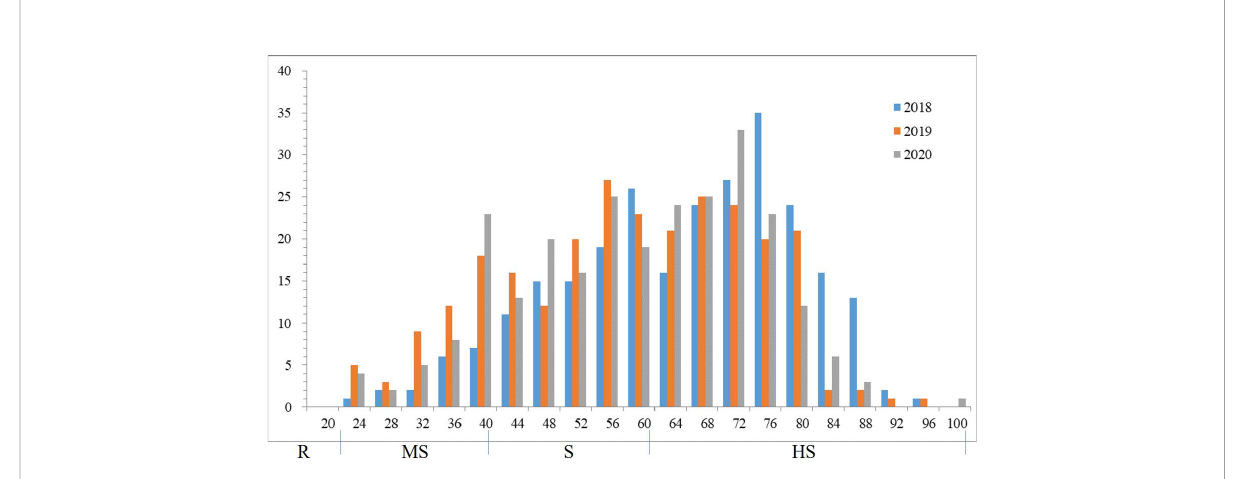
FIGURE 1 Frequency distributions of the sharp eyespot disease index in 2018, 2019 and